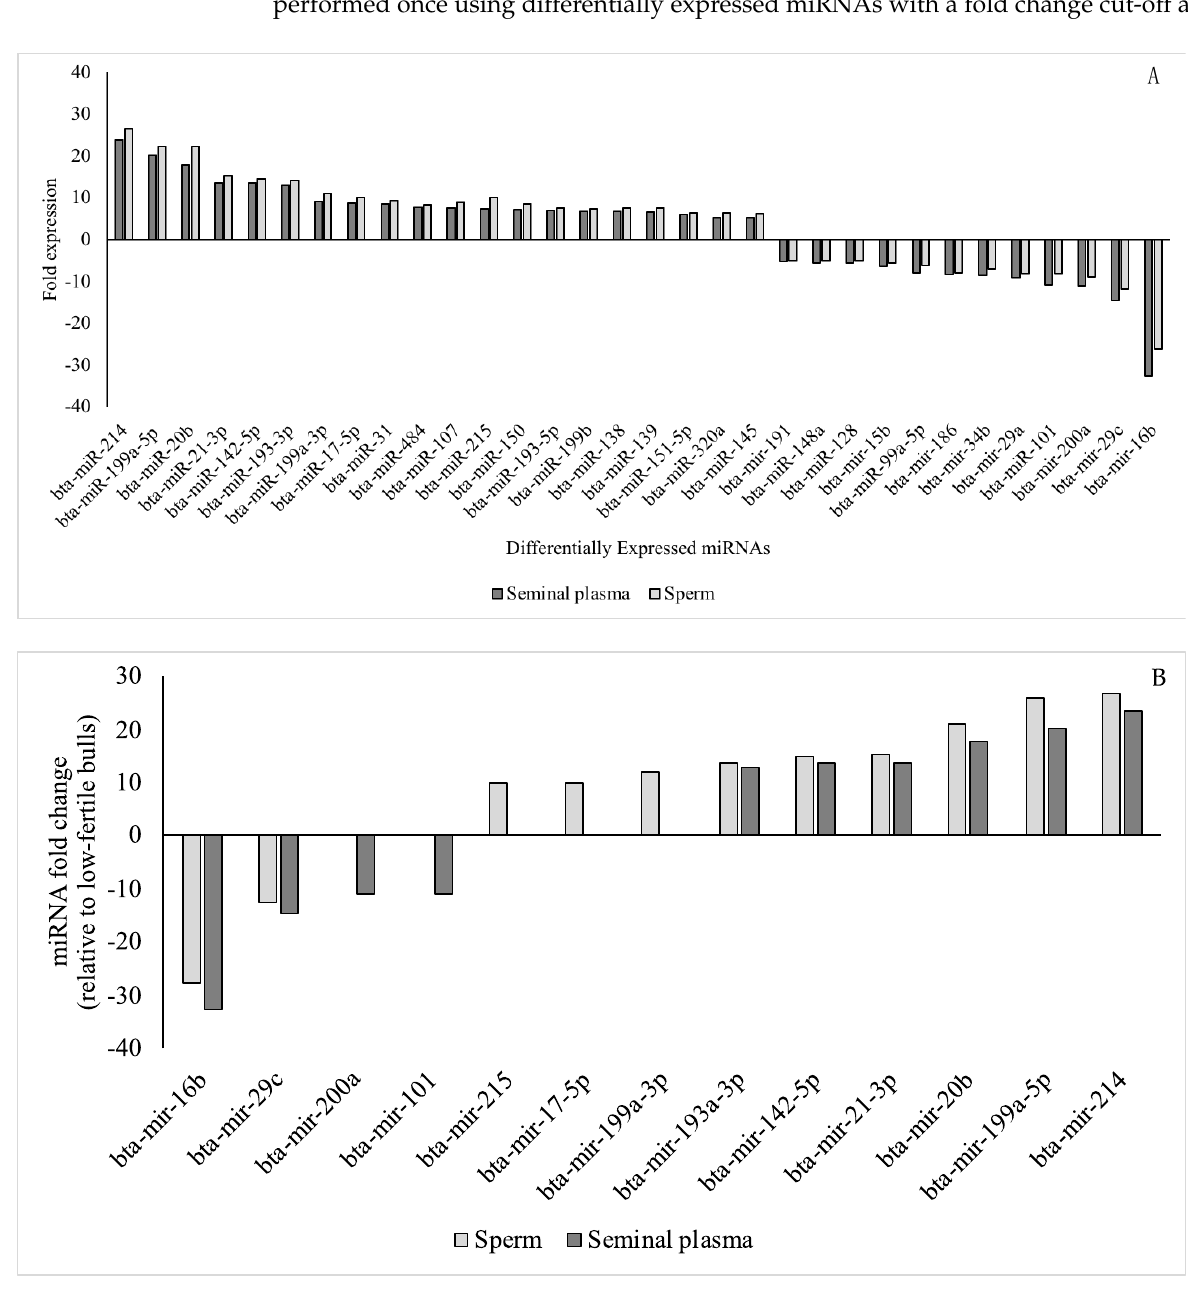
Figure 1. ( A ) Fold regulation of differentially expressed sperm and seminal plasma miRNAs in high-fertile compared to low-fertile Holstein bulls. Of 84 bovine-specific well-characterized miRNAs investigated, 20 were greater ( p ≤ 0.05; fold ≥ 5) and 12 were lower ( p ≤ 0.05; fold ≤ − 5) in sperm and seminal plasma in high-fertile Holstein bulls; ( B ) Fold regulation of highly differentially expressed sperm and seminal plasma miRNAs in high-fertile compared to low-fertile Holstein bulls. Of 84 bovine-specific well-characterized miRNAs investigated, 11 miRNA [9 upregulated ( ≥ 10) and 2 down regulated ( ≤− 10)) were differentially expressed in high compared with low-fertile sperm ( p < 0.001); whereas 10 miRNA (6 upregulated ( ≥ 10) and 4 down regulated ( ≤− 10)) were differentially expressed in high compared with low-fertile seminal